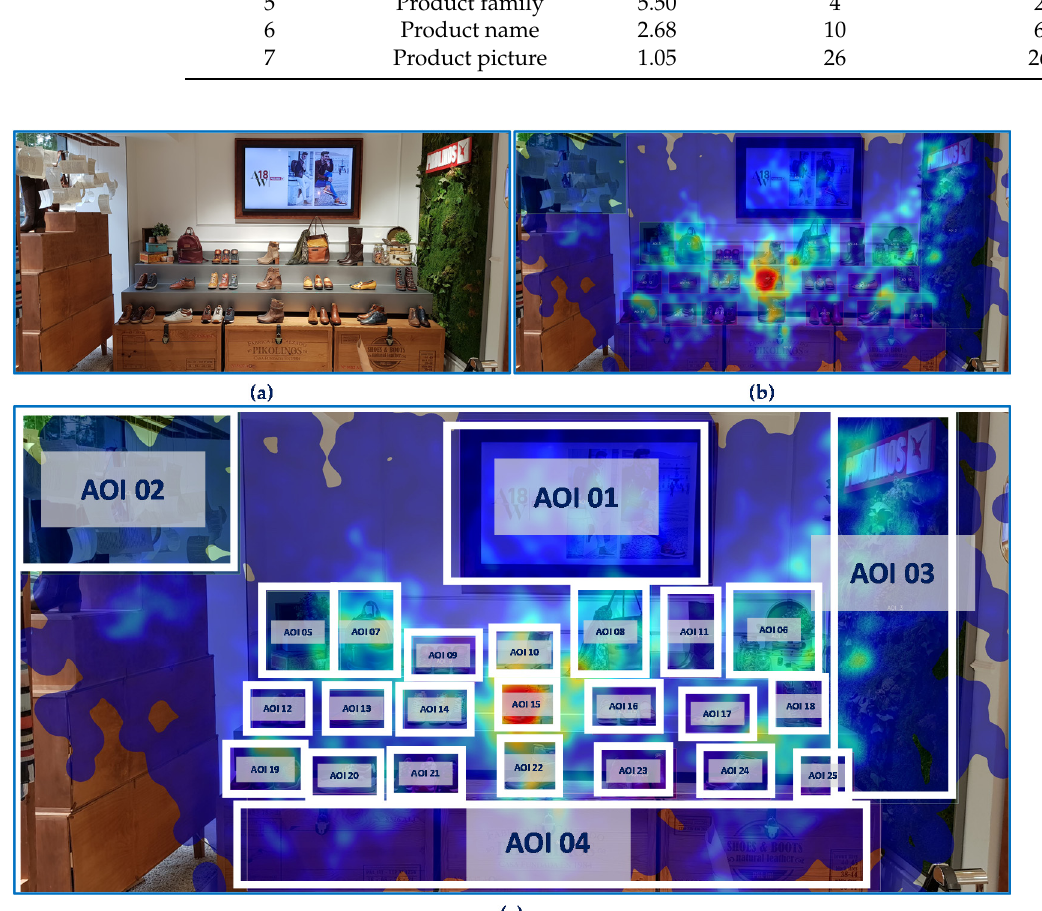
Figure 4. Footwear store area original image ( a ), heat map ( b ) and heat map with AOIs ( c ). Source: Prepared by the authors.